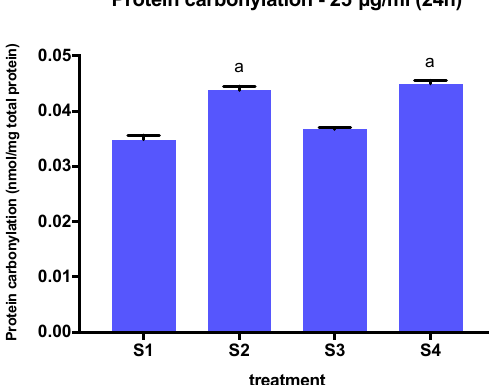
Figure 9. Protein carbonylation levels in BEAS-2B cells treated with S1–S4 soot at 25 ug/mL for 24 h. Results are expressed as nmol/mg of total protein. a: different from S1 and S3. One-way ANOVA ( p < 0.001, F (3, 12) = 63.07).